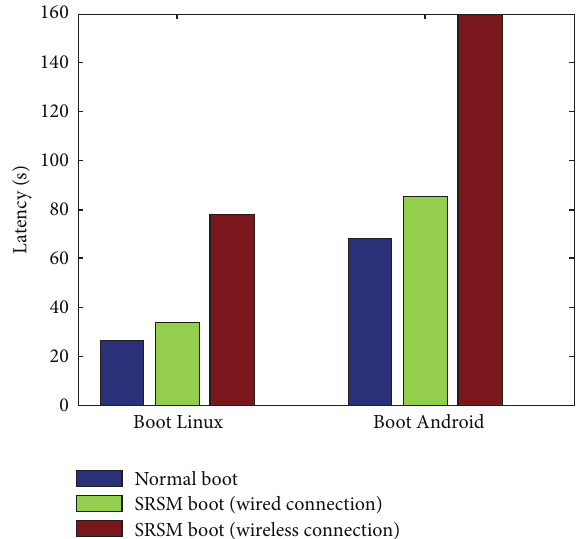
Figure 9: Multi-OS on-demand with